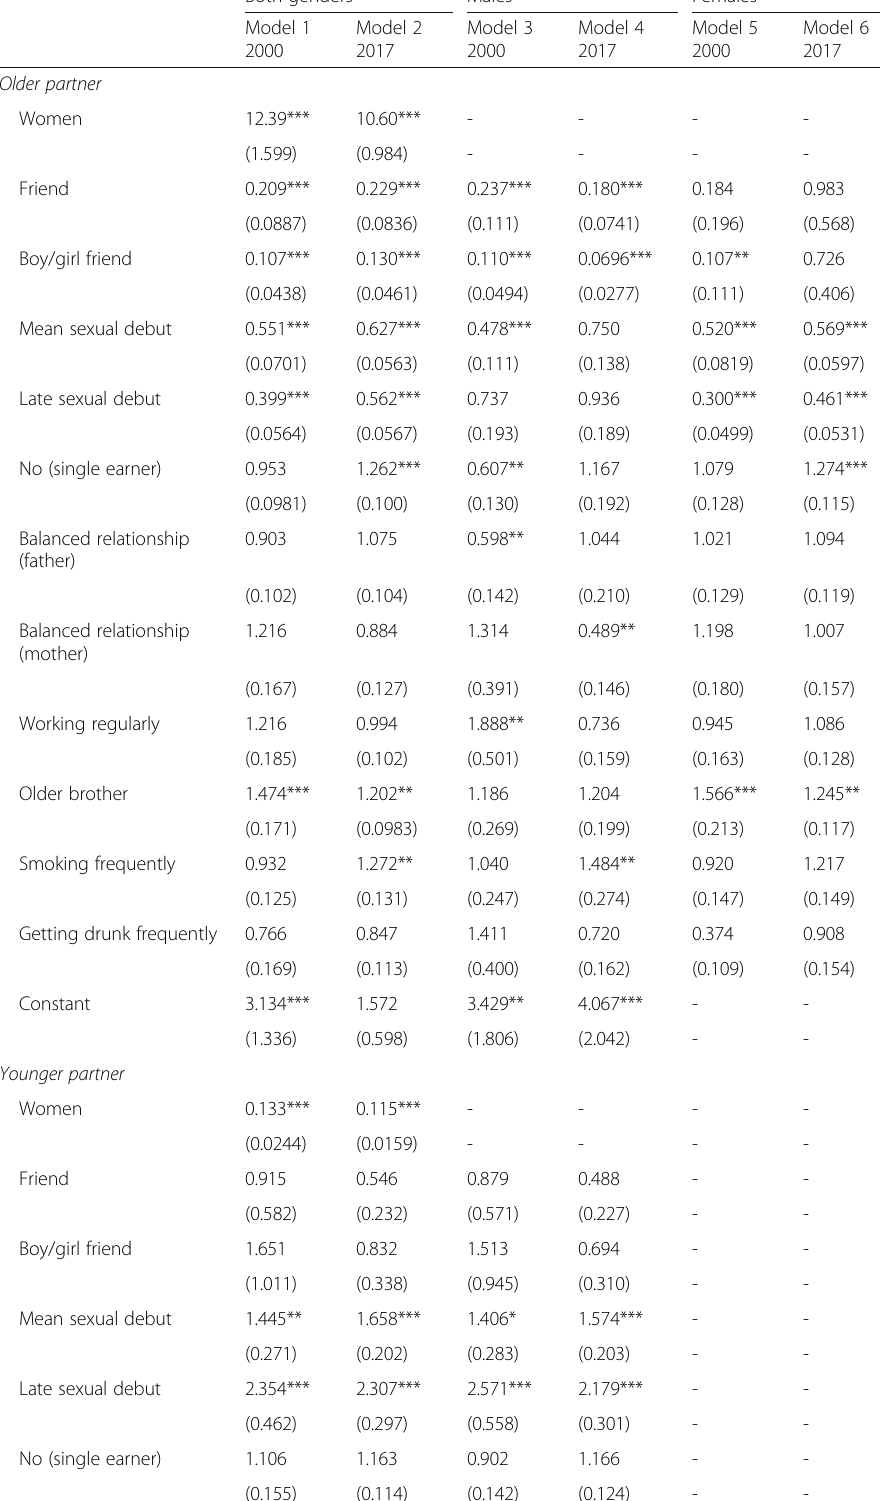
Table 7 Results of multinomial (for both genders and men) and binary (for women) logistic regression models (relative risks and odd ratios) of partners ’ age differences at first sex on key determinants and control variables for 2000 and 2017 SELFY